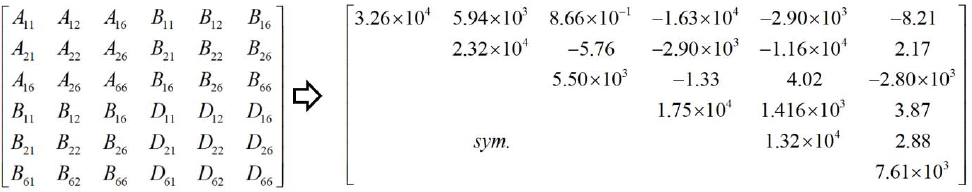
Figure 16. Equivalent stiffness matrix of bidirectional CCCP with layup configuration of [0/45/90/– 45/0]s obtained by present